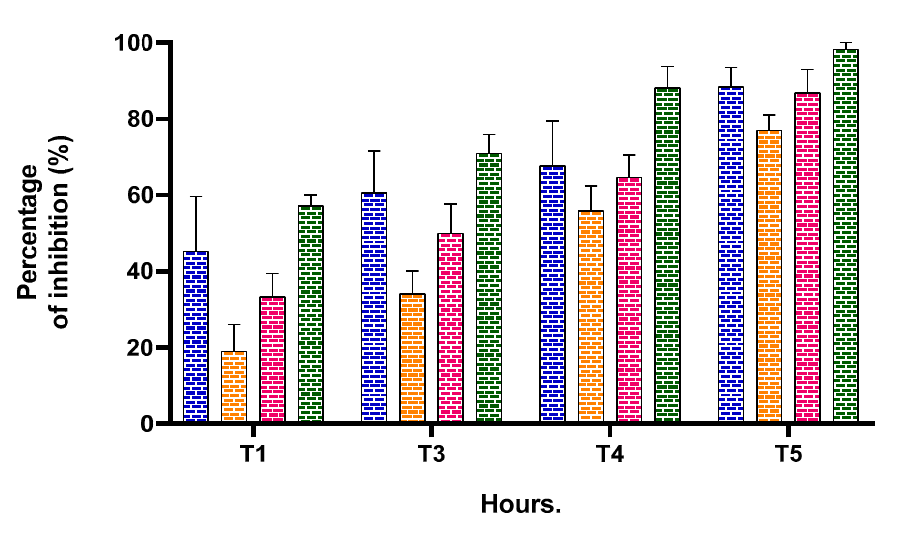
Figure 5. Percentage of edema inhibition. Values are expressed as mean ± SD ( n = 5).